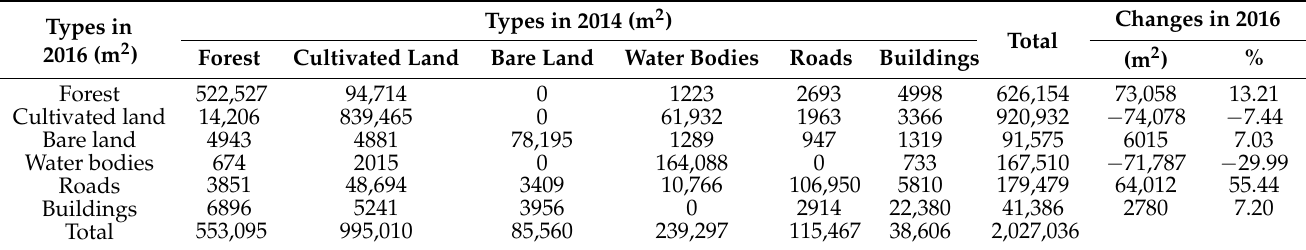
Table 7. Change matrix of six types of surface objects from 2014 to 2016 in experiment three in the study area B. Types in